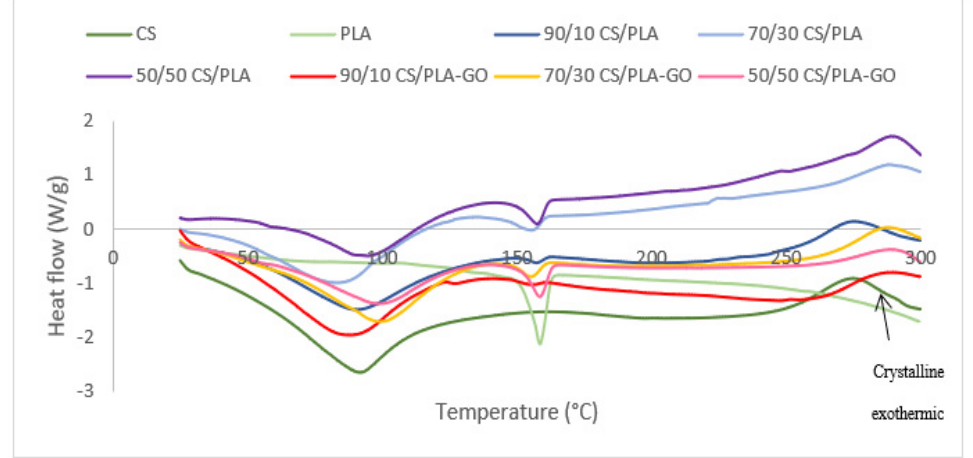
Figure 6. DSC thermograms of CS, PLA and CS/PLA with and without GO composites.